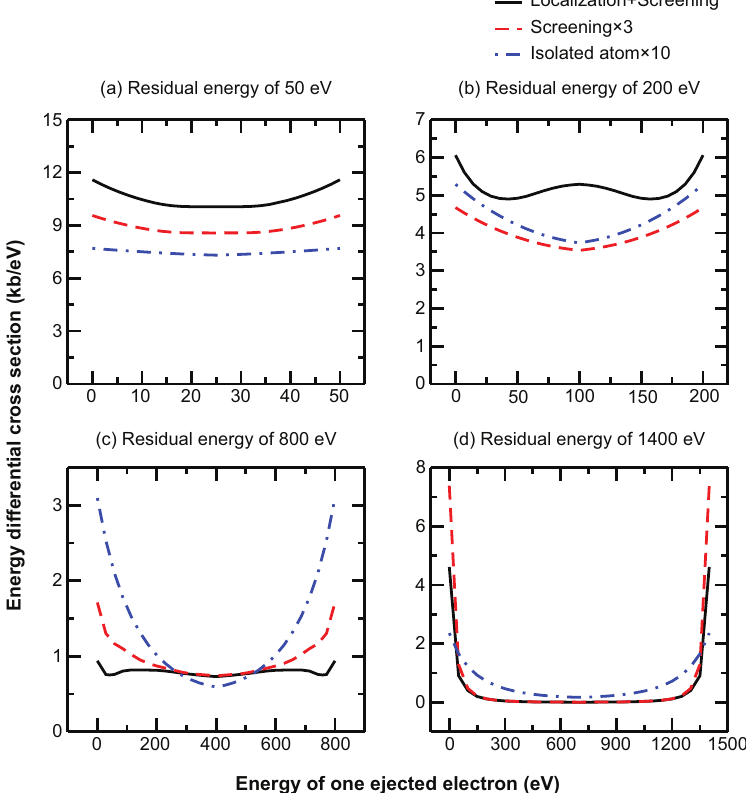
Figure 1. Energy differential cross sections of electron–ion collisional ionization. The ionization considered, e + 1 s 2 2 s 2 S → 1 s 2 1 S + 2 e of Mg 9 + , occurs in a solid-density magnesium plasma at an electron temperature of 150 eV and a density of 4.54 × 10 23 cm − 3 with residual energies of ( a ) 50 eV, ( b ) 200 eV, ( c ) 800 eV, and ( d ) 1400 eV. For clarity, the results obtained with the isolated-ion and screened-ion models are scaled up tenfold and threefold,